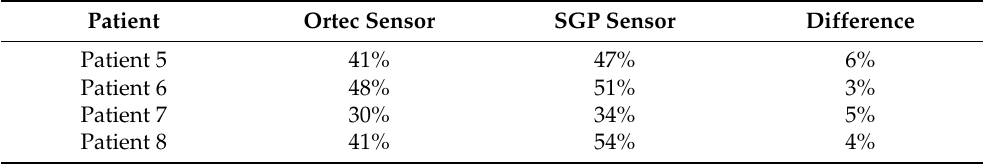
Table 2. Group B patients uptake percentages given by both sensors, and the difference between the